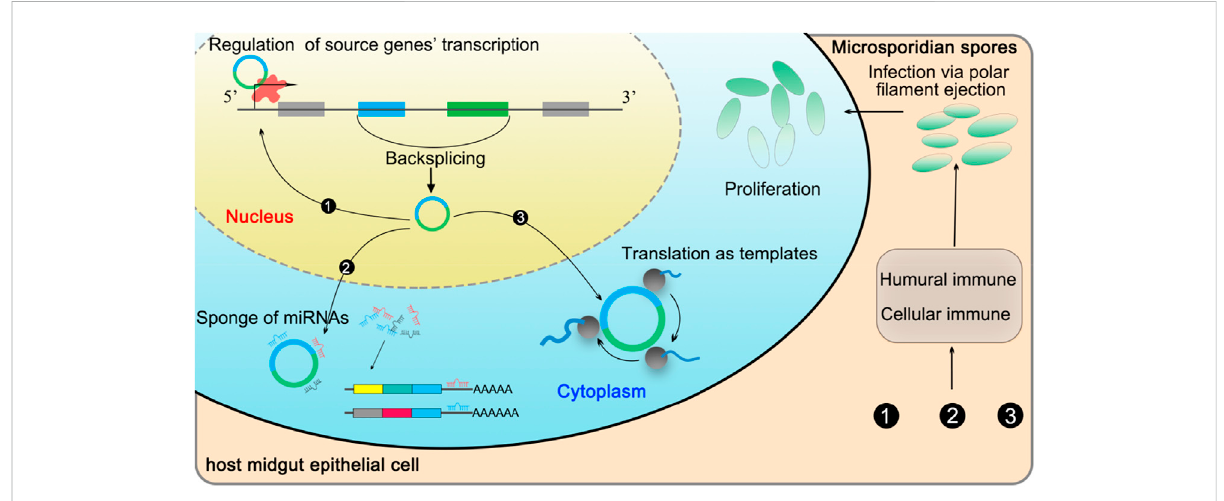
FIGURE 7 A working model of DEcircRNA-regulated response of A. c. cerana workers to N. ceranae